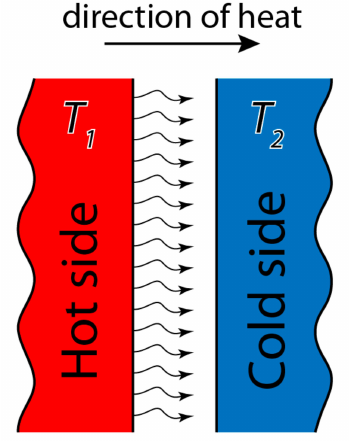
Figure 2. Thermal contact between two interfaces separated by a distance